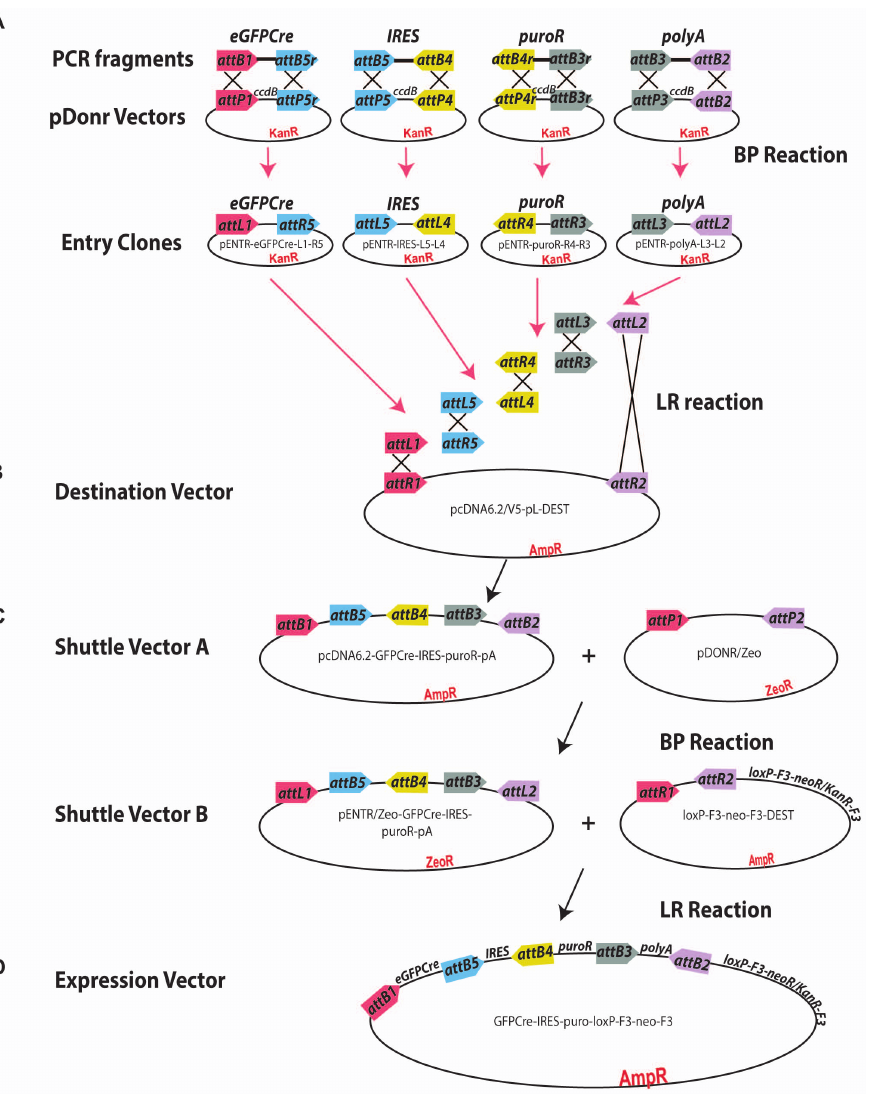
Figure 1. Generation of pMULTIrec. A. Four multisite Gateway compatible fragments (eGFPCre; IRES; puro R and pA) were PCR amplified and cloned into the appropriate pDONR vector to make four pENTR vectors. B. The four pENTR clones were combined into one four-fragment Gateway clone. C. The four-fragment cassette was moved to pDONR/Zeo to change antibiotic resistance and subsequently sub-cloned to a vector carrying a Gateway ENTR cassette upstream of a dual selection (Neo/Kan) cassette. D. The resulting pMULTIrec